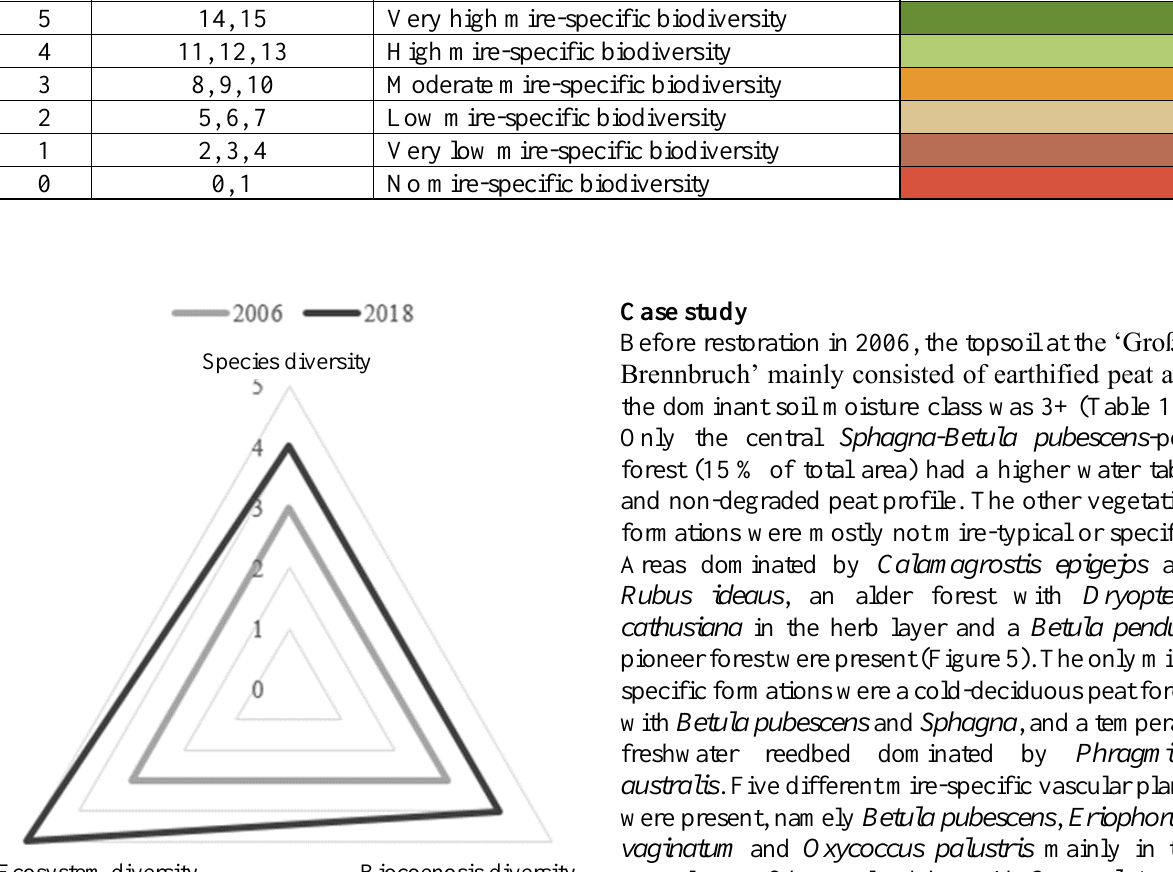
Figure 3. Visualisation of overall mire-specific biodiversity of “Großes Brennbruch” before (2006) and after (2018)